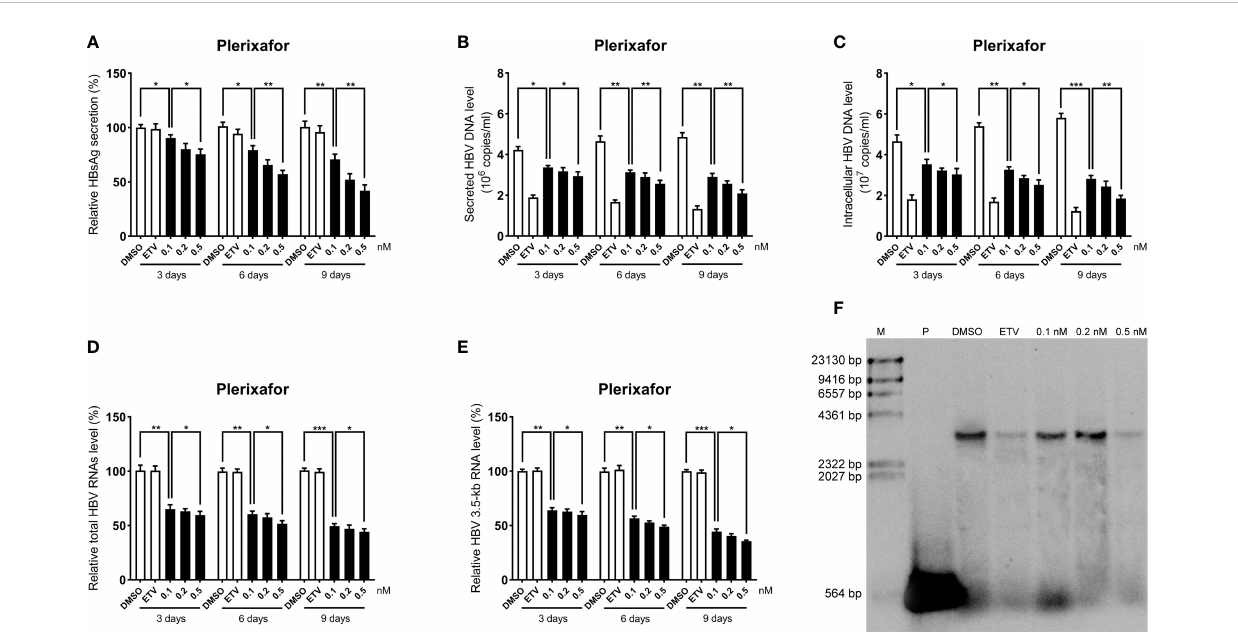
FIGURE 4 Plerixafor inhibited HBV replication in HepAD38 cells. HepAD38 cells were treated with 0.1% DMSO, 0.1, 0.2, or 0.5 nM plerixafor and 25 nM ETV for 3, 6 and 9 days. The levels of HBsAg, secreted and intracellular HBV DNA, and HBV RNAs were detected. (A) The results of the ELISA showed a decrease in the level of HBsAg in the supernatant. (B-E) Real-time PCR analysis showed that plerixafor inhibited HBV DNA both in the supernatant and cells, as well as, HBV total RNAs and 3.5-kb RNA. (F) A Southern blot analysis was performed to determine the level of HBV DNA after 9 days of